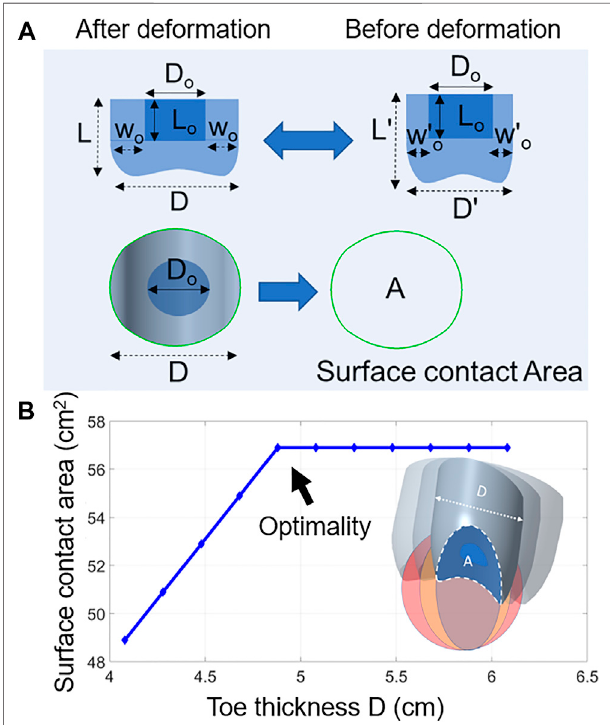
FIGURE4|(A) Aschematicofthesofttoe afterand beforedeformation. (B) A graph of toe thickness D and the surface contact area A. This was done by using Creo software to measure the soft toe ’ s contact area with the surface. Toes of various thicknesses were attached to the CAD of pipes. The software then calculated the real contact area between the toe and the